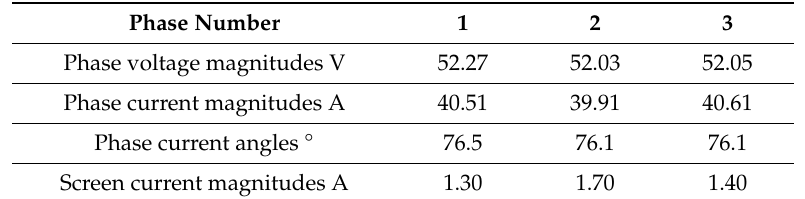
Table 8. Measured imposed voltage magnitudes, current magnitudes and angles in the phases and the induced current magnitudes in the metallic screens for case #1.